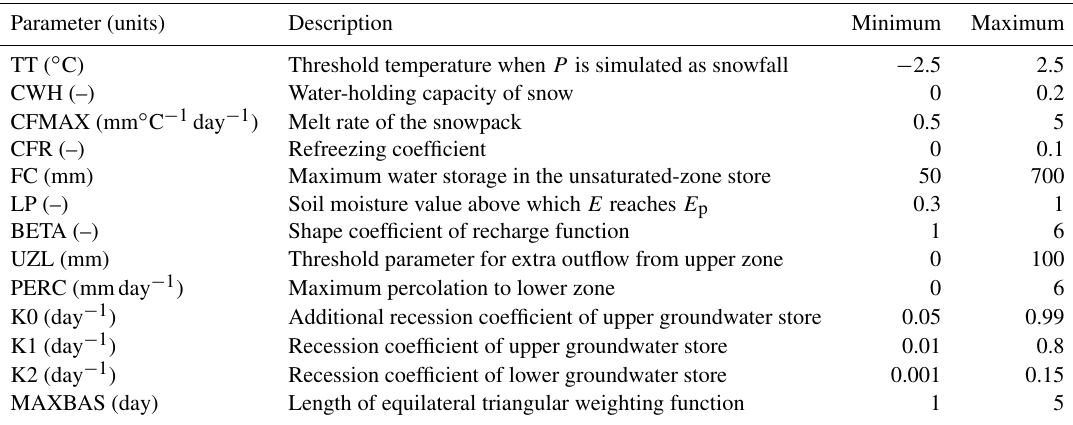
Table 3. HBV model parameter descriptions and calibration